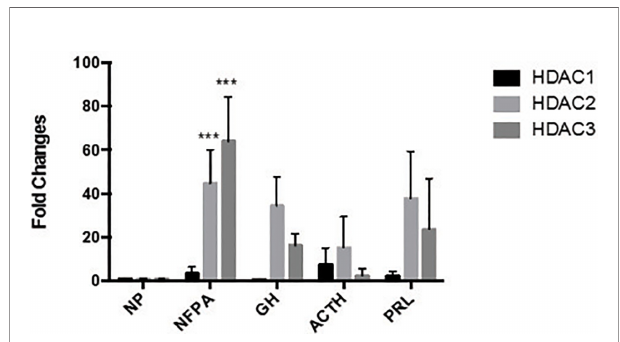
FIGURE 3 | The expression of HDAC family HDAC1, HDAC2 and HDAC3 in different types of pituitary tumors. HDAC family number HDAC1, HDAC2 and HDAC3 expressed in normal pituitary (NP, n = 11) and clinically non-functioning pituitary adenomas (NFPA, n = 22), growth hormone secreting tumors (GH, n = 6), adrenocorticotropic hormone secreting tumors (ACTH, n = 6) and prolactin secreting tumors (PRL, n = 6), ***P <